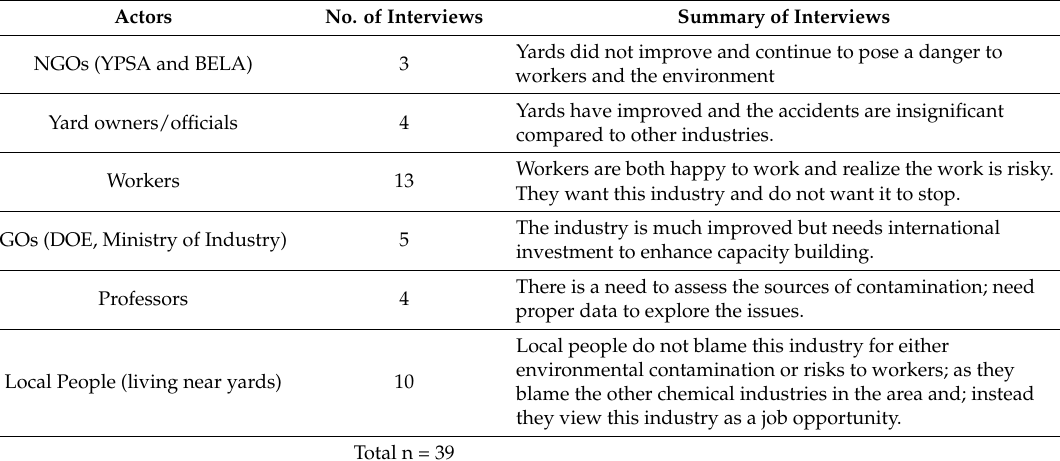
Table 1. Actors and perspectives revealed through open-ended interviews in